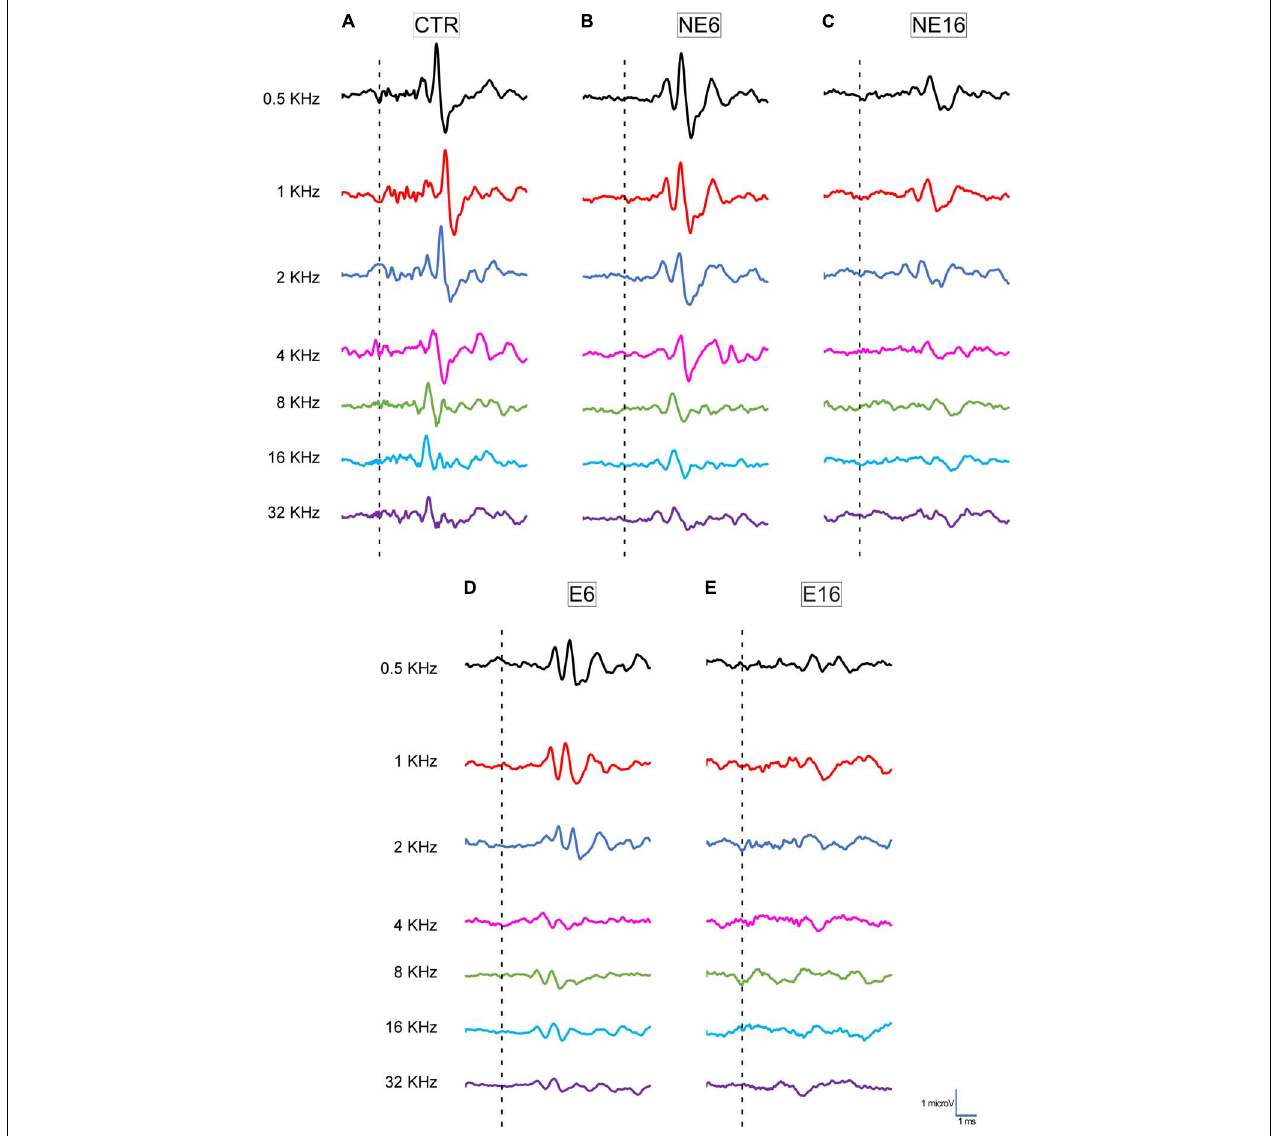
FIGURE 1 | Line graphics of representative ABR traces from 3-month-old control rats (CTR) and from non-exposed (NE6 and NE16) and NAP-exposed (E6 and E16) rats for all frequencies tested. CTR (A) and NE6 (B) rats presented a similar recording pattern with the distinctive 4–5 waveforms after stimulus onset. In NE16 (C) rats, there was a characteristic decrease in the amplitude of all waves for all frequencies evaluated. In NAP-exposed rats, reduced wave amplitude was already detected at six months of age (D) and was more profound after 16 months (E) compared to CTR and non-exposed animals (A,B) . Dashed lines indicate stimulus onset. Stimulus intensity = 80 dB SPL; n = 4 for each animal